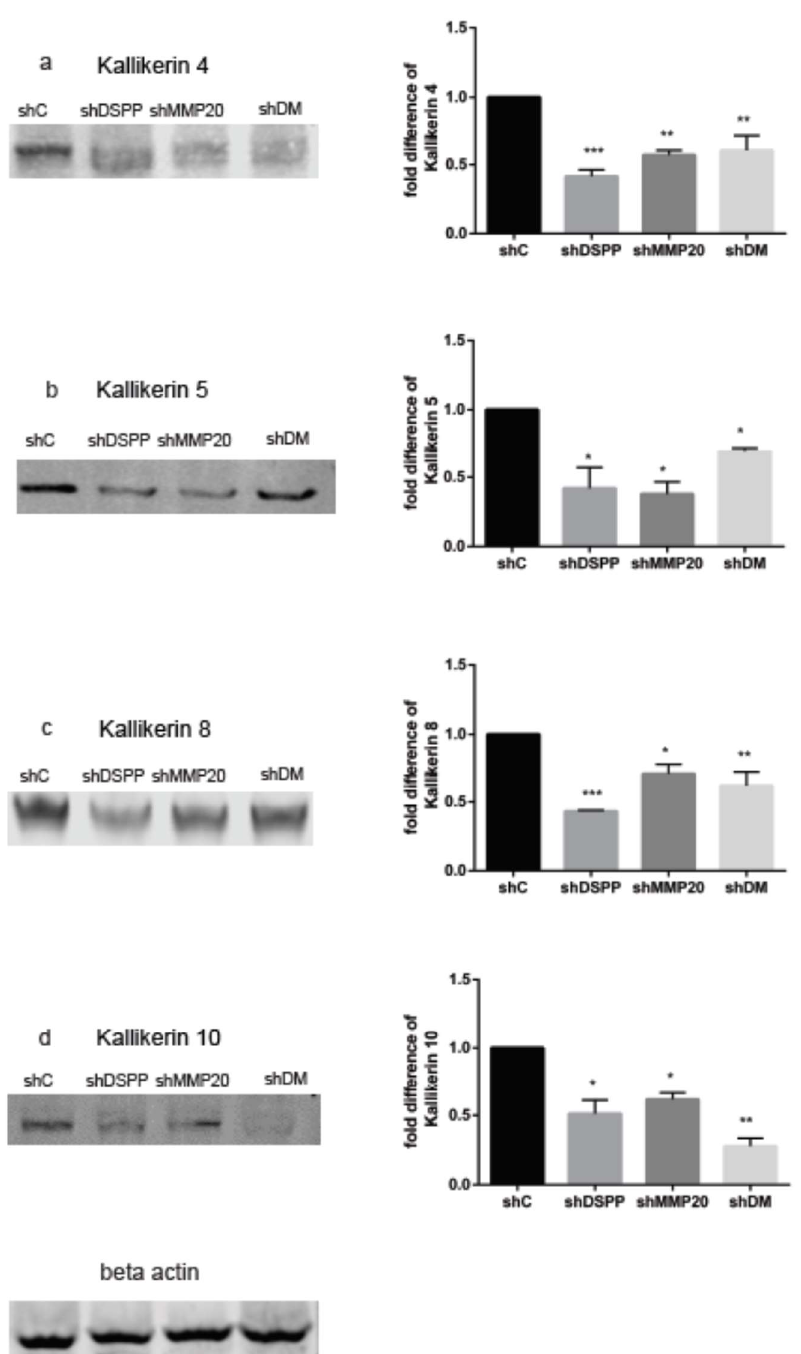
Figure 3. WB analysis of kallikreins levels in DSPP and MMP20 silenced OSC2 cells. ( a ) Downregulation of KLK4 in shDSPP (60%), shMMP20 (40%), and shDM (43%) were significant ( p < 0.001, 0.01) compared to the control. ( b ) Downregulation of KLK5 in shDSPP (66%), shMMP20 (73%), and shDM (35%) were significant ( p < 0.05) compared to the control. ( c ) Downregulation of KLK8 in shDSPP (53%), shMMP20 (35%), and shDM (47%) were significant ( p < 0.001, 0.05, 0.01) when compared to the control. ( d ) Downregulation of KLK10 in shDSPP (48%), shMMP20 (37%), and shDM (73%) were significant ( p < 0.05, 0.01) when compared with the control. Beta actin was used as the internal control. Values are given as mean ± SE for 3 independent experiments. shC = Scrambled Control; shDSPP = DSPP Silenced OSC2 cells; shMMP20 = MMP20 Silenced OSC2 cells; DM = Combined DSPP–MMP20 Silenced OSC2 cells; * p < 0.05; ** p < 0.01; *** p < 0.001.